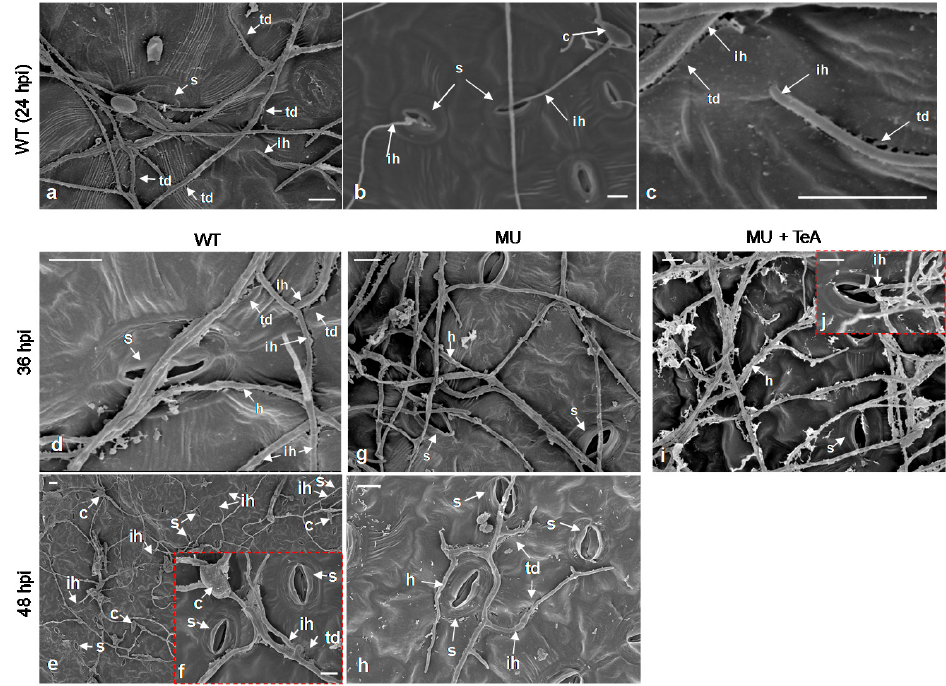
Figure 3. TeA is important for hyphal penetration of A. adenophora by A. alternata . A. adenophora leaves inoculated with A. alternata wild-type (WT, a – f ), mutant ∆ HP001 (MU, g , h ), conidia (8 × 10 5 conidia mL − 1 ) or mutant conidia with TeA (20 μ g mL − 1 , MU+TeA, i , j ) were observed using scanning electron microscopy at 24, 36, and 48 h post inoculation (hpi). Note that visual differences between WT and MU were present during hyphal penetration and invasive hyphal colonization. Here, s: Stomata; c: Conidium; h: Hypha; ih: Invasive hypha; td: Tissue destroyed. Scale bars = 10 μ m. One representative result out of three repetitions is